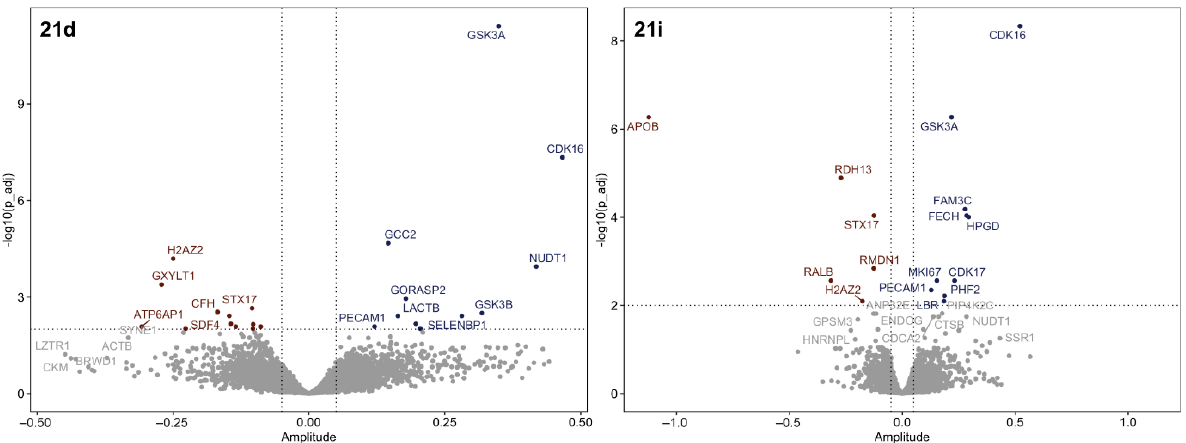
Figure 6. Volcano plots of stabilized (positive amplitude) and destabilized (negative amplitude) proteins of 21d and 21i .